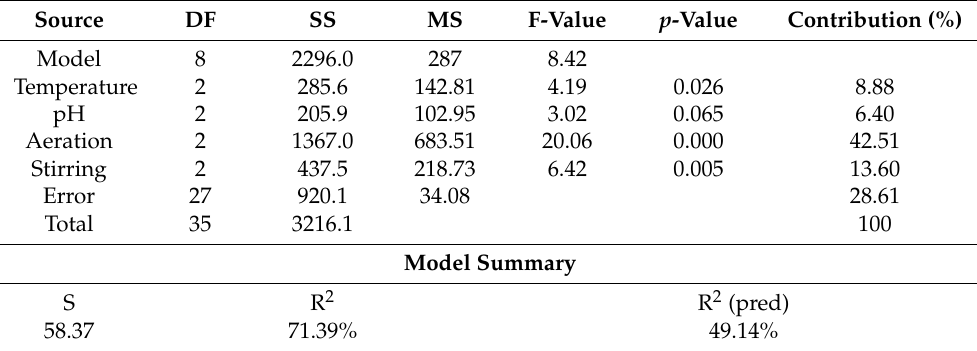
Table 3. Analysis of